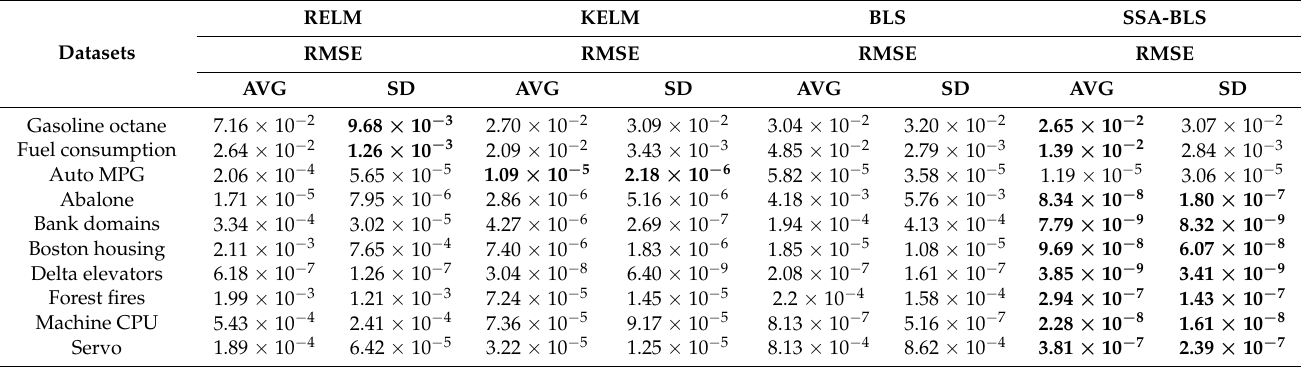
Table 4. The RMSE of the four algorithms on the testing set.